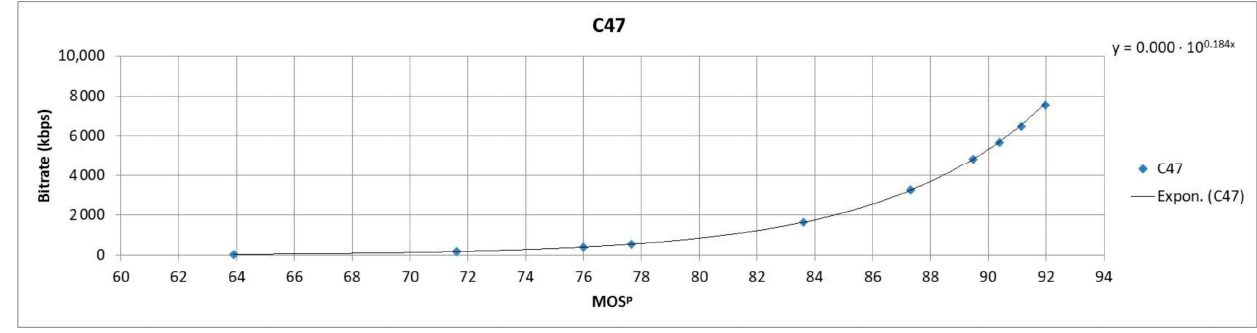
Figure 7. Bitrate- 𝑀𝑂𝑆 (cid:3043) curves for C47 video sequence. Figure 7. Bitrate- MOS p curves for C47 video